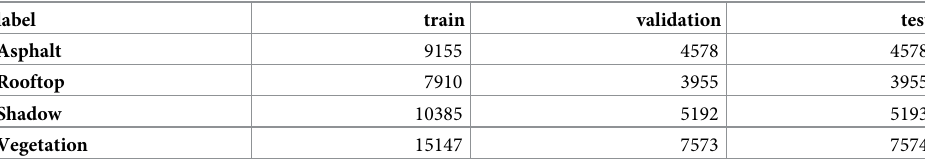
Table 1. Splits of train, test, and validation samples for Suburban dataset.